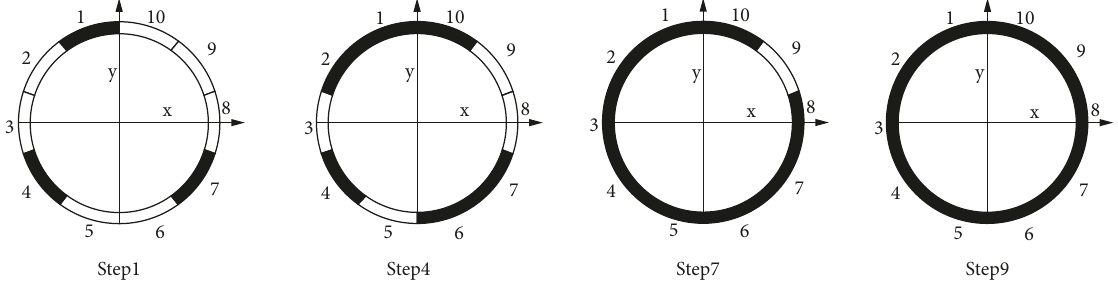
Figure 6: Installation of panel at select step.